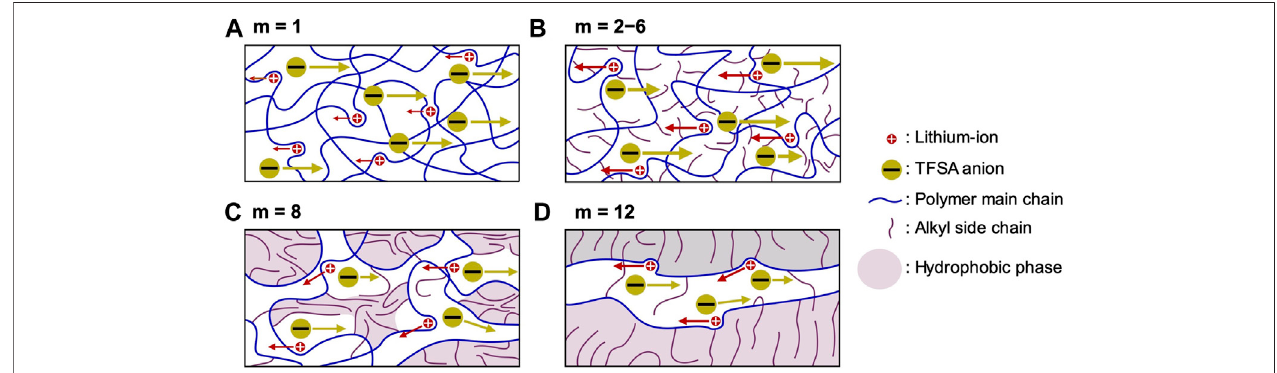
FIGURE7| ProposedmodelforiontransportationwithinPCmEO-LiTFSA. (A) m =1;ethergroupinteractswellwithlithium-ionandisolatestheTFSAanion, (B) m = 2 − 6; alkyl side chain dispersed and suppressed the interaction between ether group and lithium-ion as well as TFSA anion and lithium-ion, (C) m = 8; alkyl side chain partially aggregates and inhibits the transport of ions, and (D) m = 12; alkyl side chain aligned via hydrophobic interaction and provide rapid lithium-ion transport pathways. Red and yellow circles correspond to the lithium-ion and TFSA anion, respectively. Blue and purple curves represent polymer main chain with ether group and alkyl side chain, respectively. The purple area shows a hydrophobic phase with alkyl side chain aggregation.